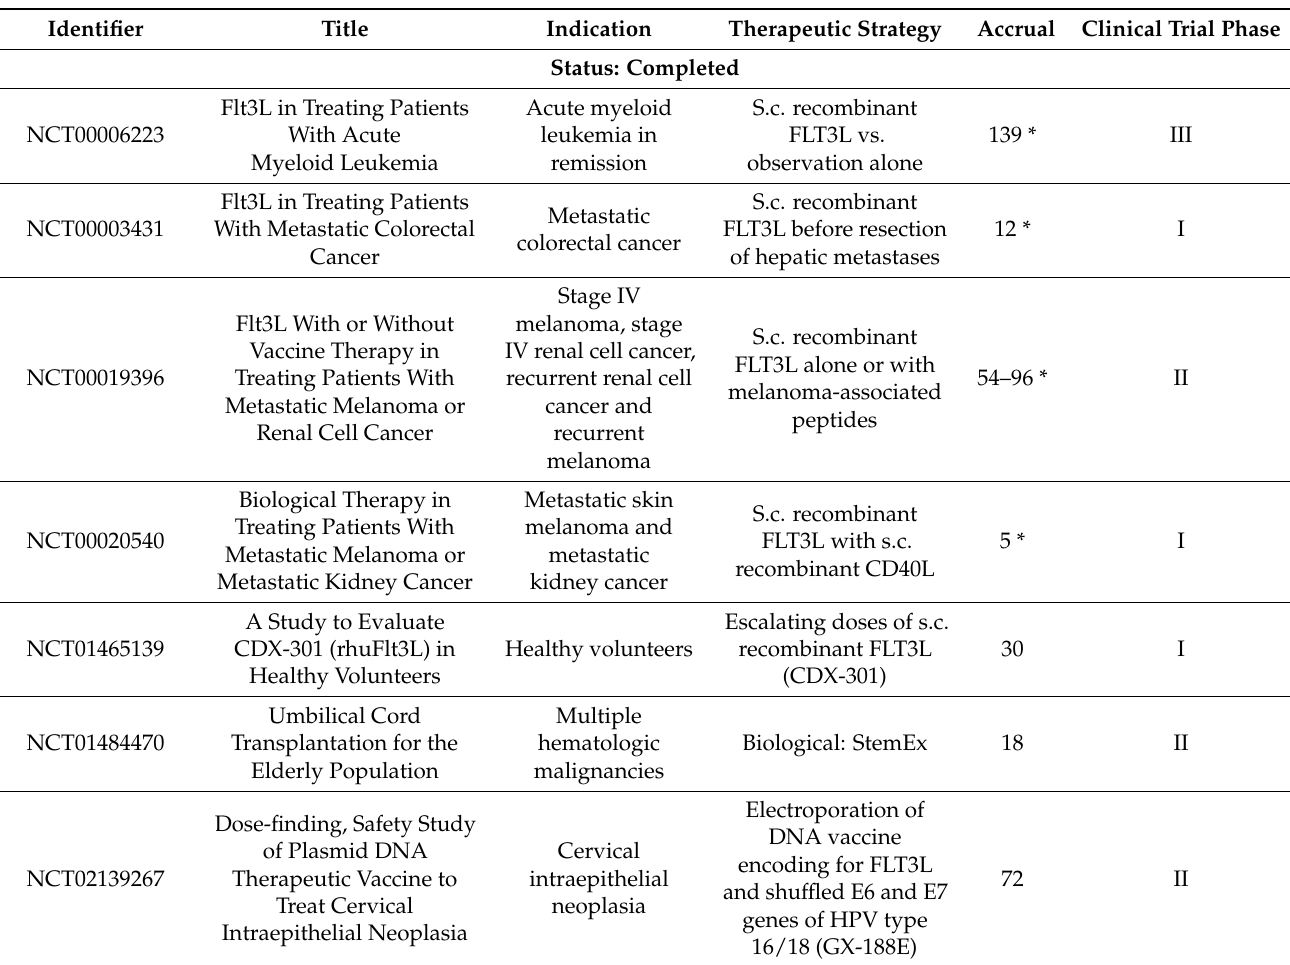
Table 1. Clinical Trials targeting the Flt3 receptor. Clinical trials registered in ClinicalTrials.gov where FLT3L has been used with immunostimulatory ends. This table includes clinical trials reported by 24 November 2020. Note that FLT3L is often used in a cytokine cocktail to expand hematopoietic precursors to improve the efficacy of bone marrow transplantation [95], but those have been excluded. s.c.: subcutaneous * Estimated